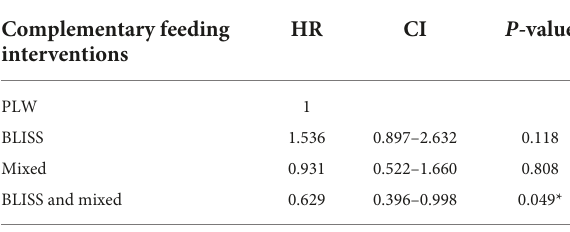
TABLE 2 Risk of exposure to ultra-processed foods (UPFs) in the first year of life, according to complementary feeding (CF) interventions groups, Brazil,